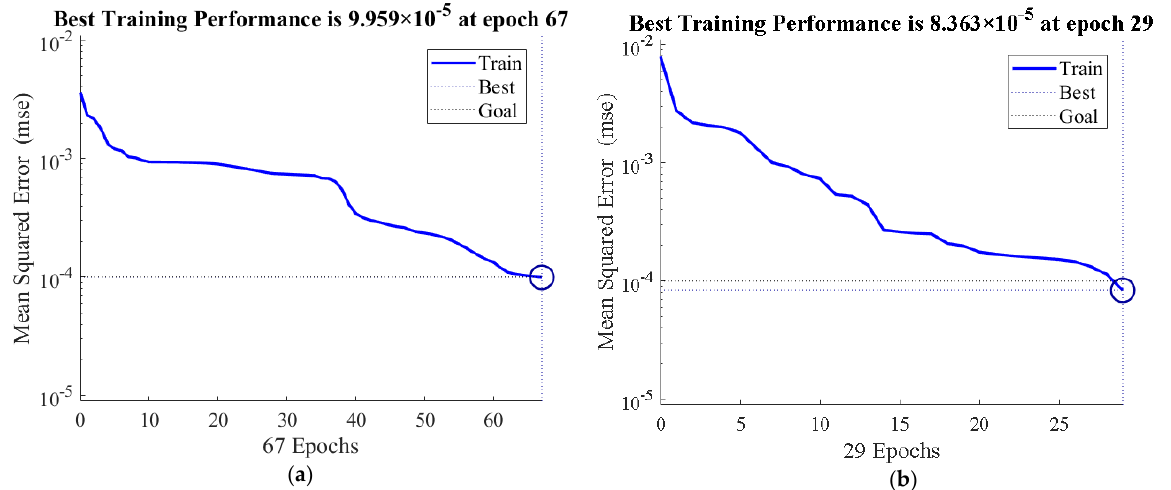
Figure 4. Comparison of BPNN and AFSA − BPNN algorithm iterations. ( a ) Iteration times of BPNN algorithm,( b ) Iteration times of AFSA-BPNN algorithm.